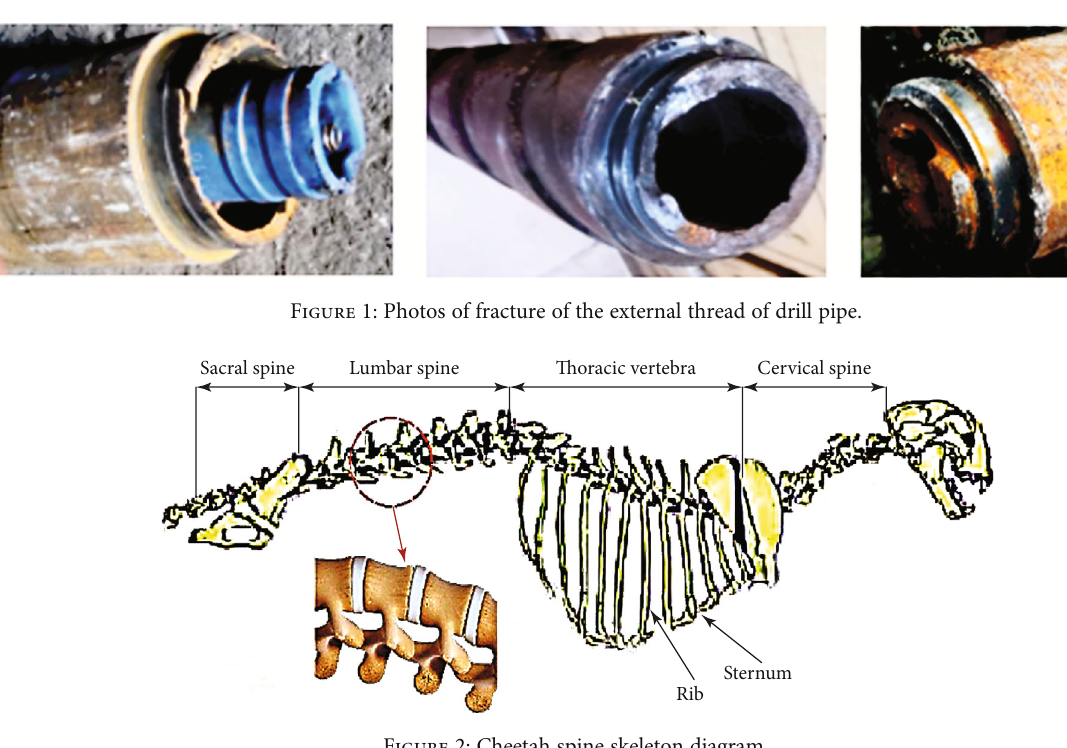
Figure 2: Cheetah spine skeleton